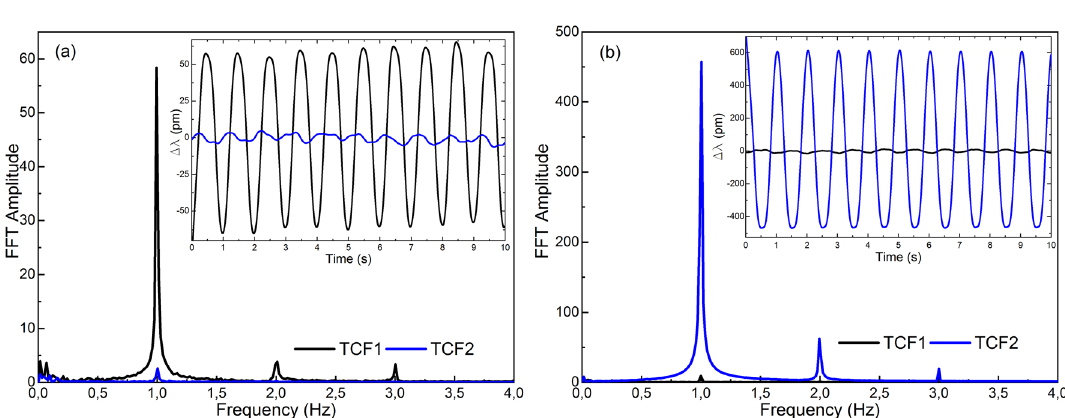
Figure 6. Results in frequency domain when ( a ) TCF1 was vibrating and TCF2 was inactive, and ( b ) TCF1 was inactive and TCF2 was vibrating. In the insets, the results in time domain of each case are